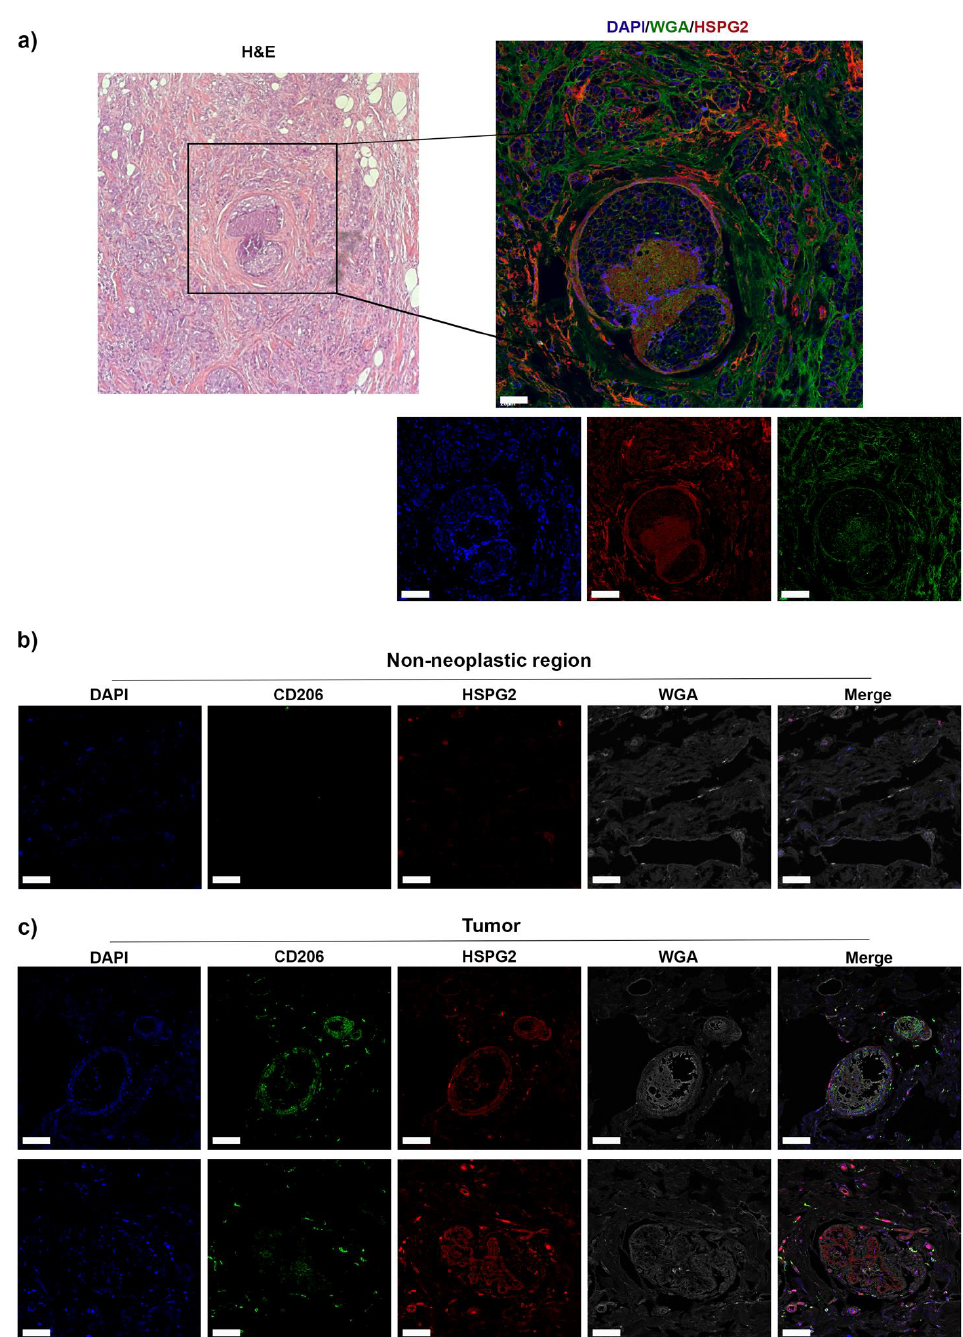
Figure 1. Human triple-negative breast cancer tissue analysis. ( a ) Left panel: Immunohistochemical analysis showing HE staining in malignant tissues was used to identify high cellular density areas and cancer islets. Right panel: Immunofluorescence analysis on the same section was performed to stain HSPG2 in red, and the tissue section was counterstained in green with WGA. Immunofluorescence analysis on sections of tissues derived from the same patients on ( b ) non-neoplastic surrounding tissue and ( c ) tumoral tissue were performed to stain HSPG2 in red and CD206 + macrophages in green. Nuclei were counterstained with DAPI, and the tissue section in gray with WGA. Scale bars represent 40 µ m. The representative images derived from qualitative analysis of TNBC biopsies of n = 3